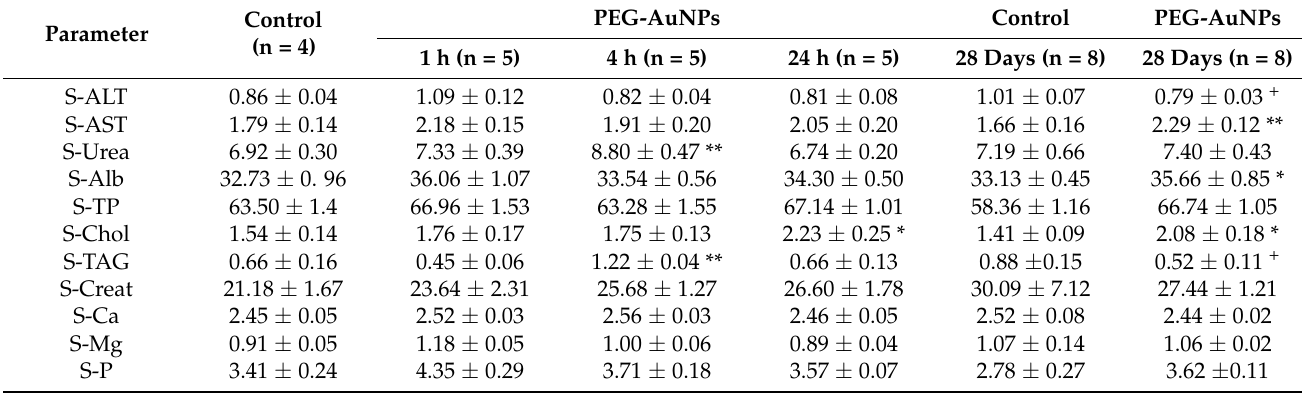
Table 6. Biochemical parameters in rat blood at 1 h, 4 h, and 24 h post-injection of PEG-AuNPs.